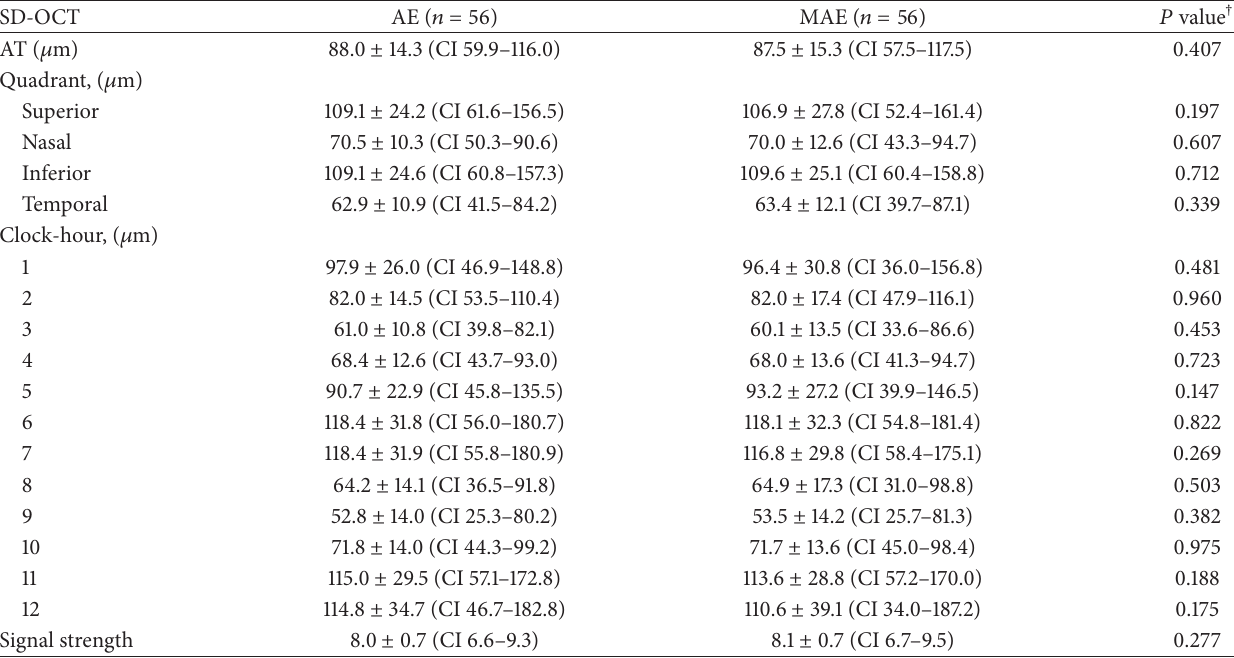
Table 2: Comparison of mean ± standard deviation (95% confidence interval) SD-OCT parameters between eyes with and without misalignments in any of the 4 sectors.